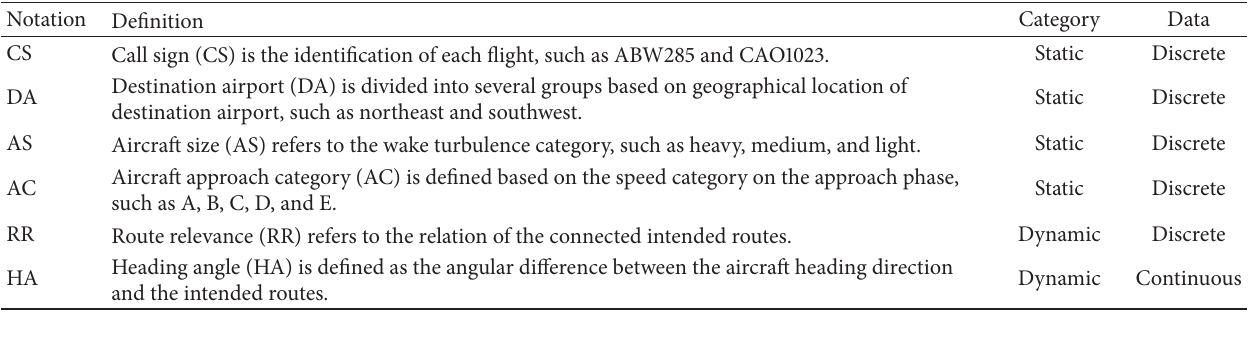
Table 1: Notation and definition of flight attributes.